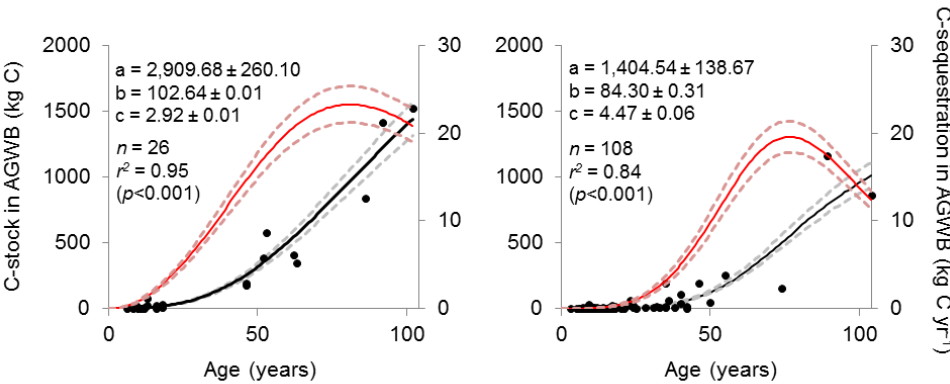
Fig. 4. C-stocks (black curve) and C-sequestration (red curve) of AGWB from Vochysia divergens and other tree species from northern Pantanal wetland forests related to tree ages. Indicated parameters are for Eq. (11). The dotted lines indicate the standard